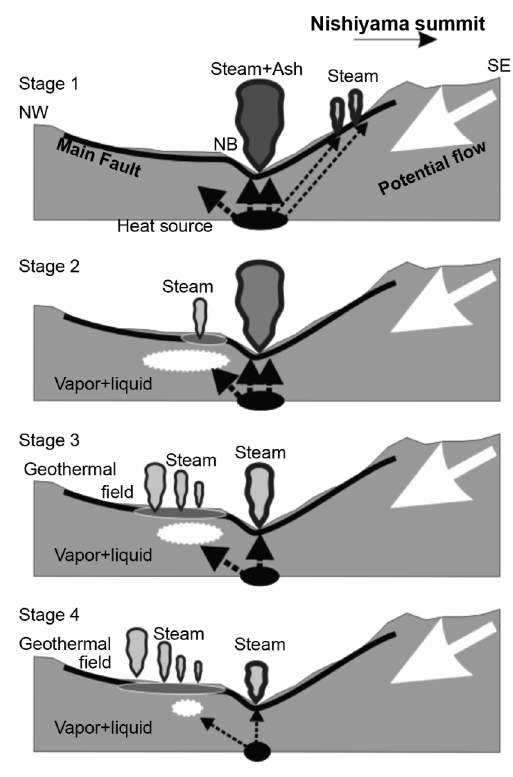
Fig. 9. Schematic models of evolution of the geot- hermal activities. Thickness of arrows depend quali- tatively on assumptions of the thermal energy supply from the intruded magma. Height of steam is also shown